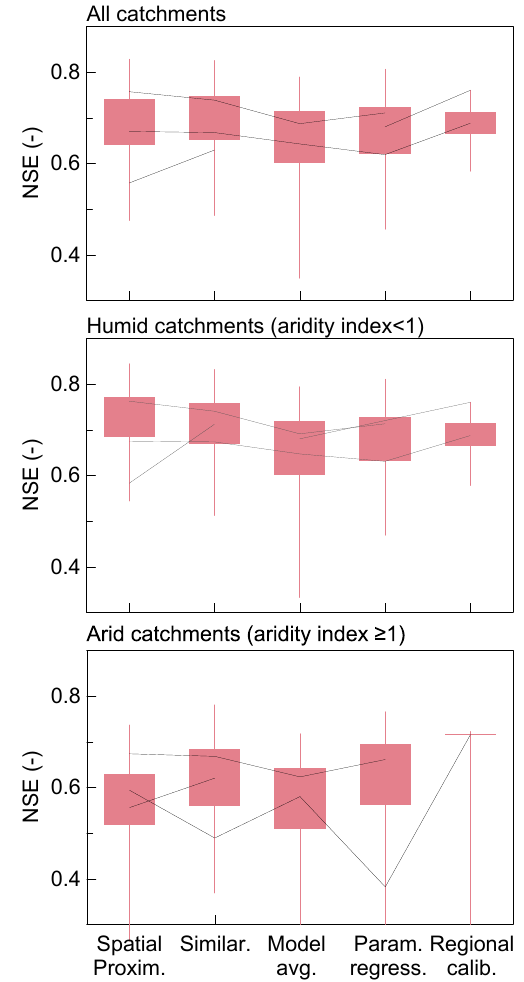
Fig. 9. Nash–Sutcliffe efficiency of predicting hydrographs in un- gauged basins for different regionalisation methods, stratified by aridity (Level 2 assessment). Top: all catchments. Centre: humid catchments (aridity index < 1). Bottom: arid catchments (aridity index ≥ 1). Lines connect median efficiencies for the same study. Boxes are 40-60% quantiles, whiskers are 20–80%